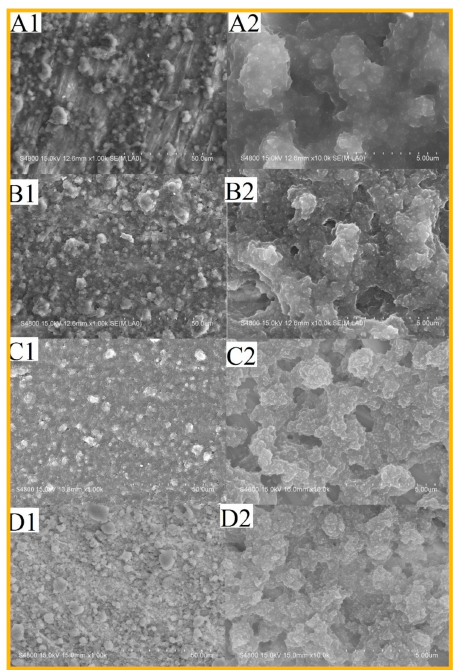
Figure 6. Scanning electron micrographs of the surfaces with di ff erent contents of silica particles viewed at 1000 × magnification. ( A1 ) 15 wt.%, ( B1 ) 20 wt.%, ( C1 ) 25 wt.%, ( D1 ) 30 wt.%, and 10,000 ×